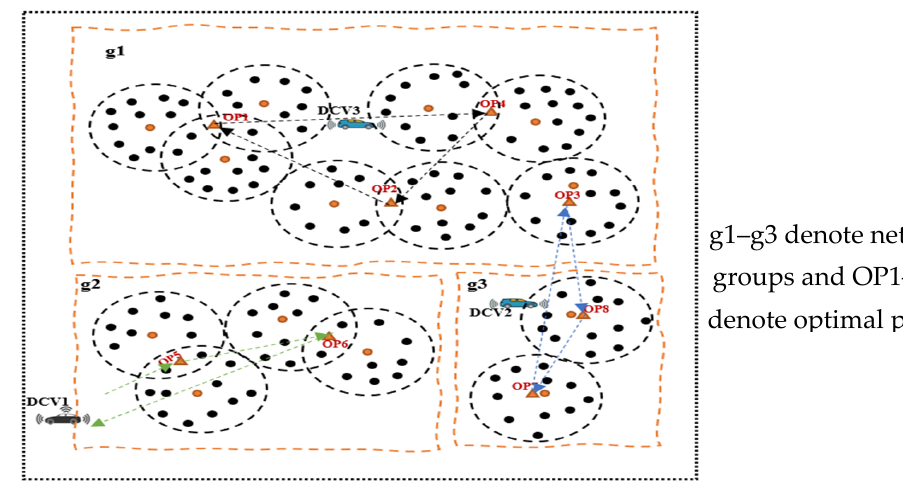
Figure 3. A working model of the proposed approach in an LS-WSN.